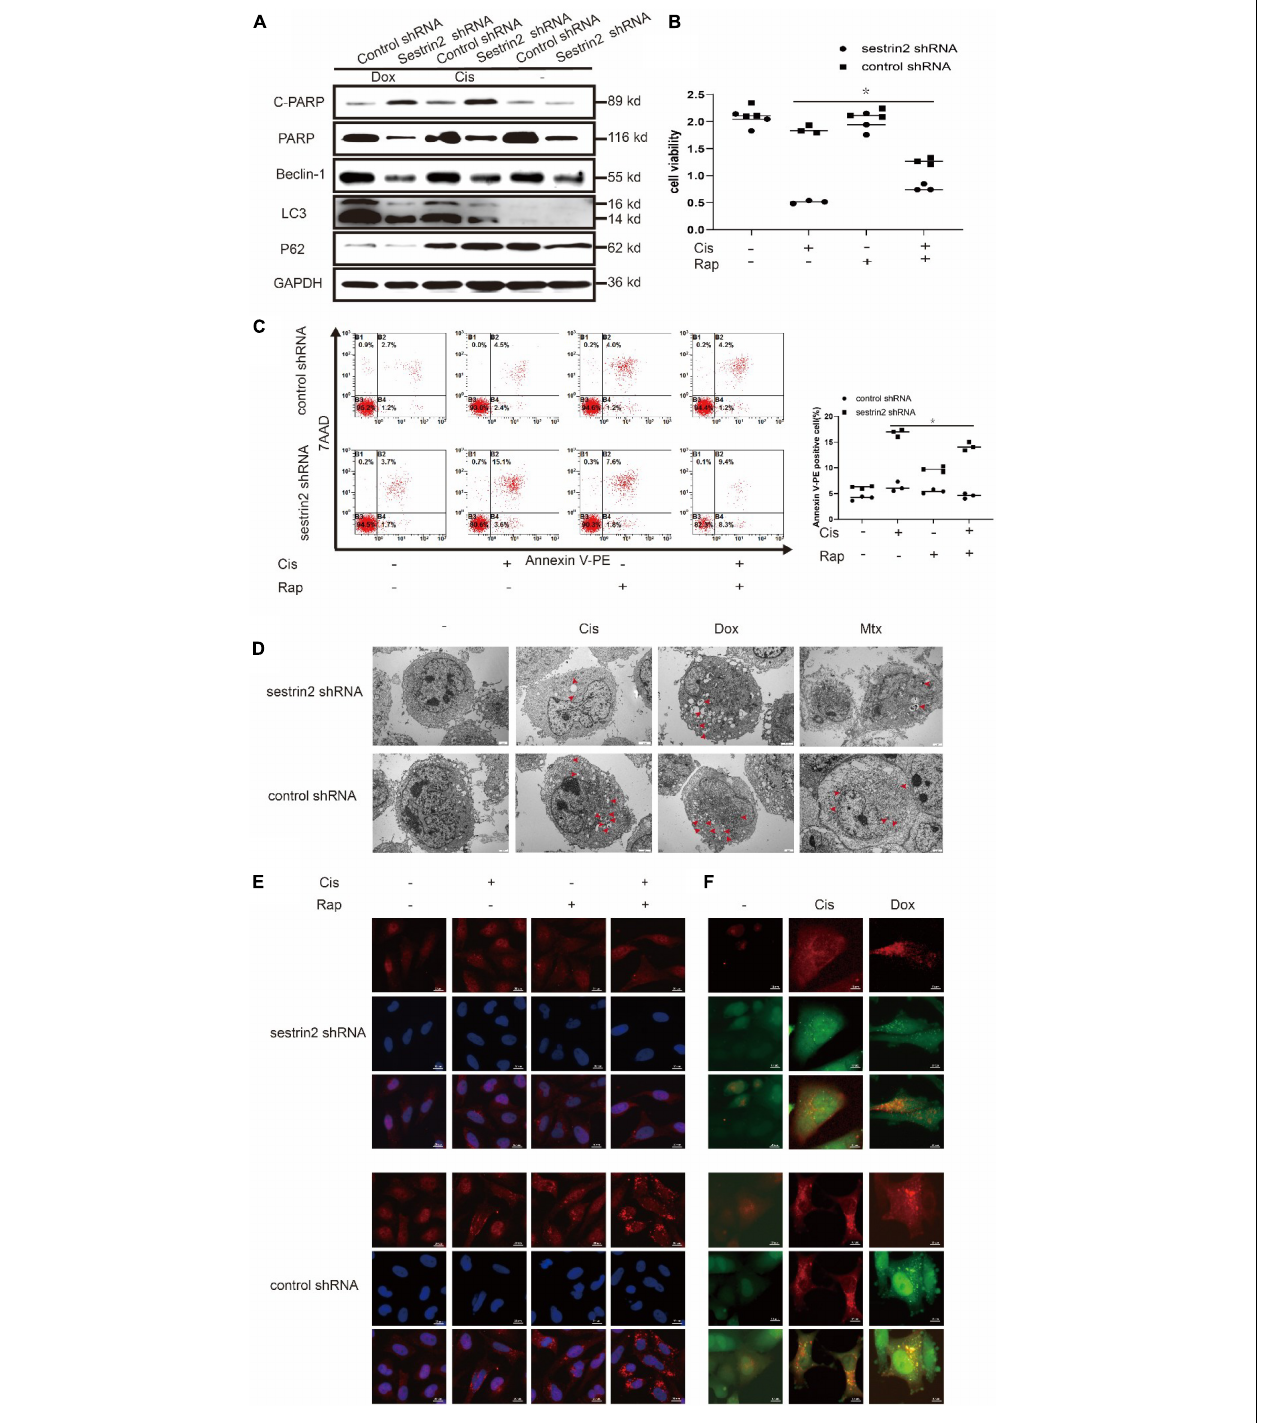
FIGURE 3 | Knockdown of SESN2 resulted in inhibited autophagy and increased apoptosis of osteosarcoma cells treated with chemotherapy. After treatment with Cis (20 µ mol/L), Dox (0.2 µ g/mL), or Mtx (50 µ mol/L) for 24 h, SESN2-knockdown and control cells were subjected to western blot to detect the expression of cleaved and total PARP, LC3, and P62 expression levels (A) ( n = 3). SESN2-knockdown HOS cells were treated with Cis (20 µ mol/L) for 24 h with or without rapamycin (100 nmol/L) for 6 h. Proliferation was analysed by CCK-8 assay (B) ( n = 3), apoptosis was assessed by Annexin V-PE/PI staining (C) ( n = 3), and LC3 puncta formation was analysed by immunofluorescence (E) ( n = 3, scale bar = 20 µ m). Intracellular autophagosomes were observed by TEM (D) ( n = 3, scale bar = 2 µ m), and autophagic flux was monitored by fluorescence microscopy in HOS cells with transient expression of GFP-RFP-LC3 in HOS cells (F) ( n = 3, scale bar = 10 µ m). The data are presented as the mean ± SD. * p < 0.05 vs. the Control shRNA group.